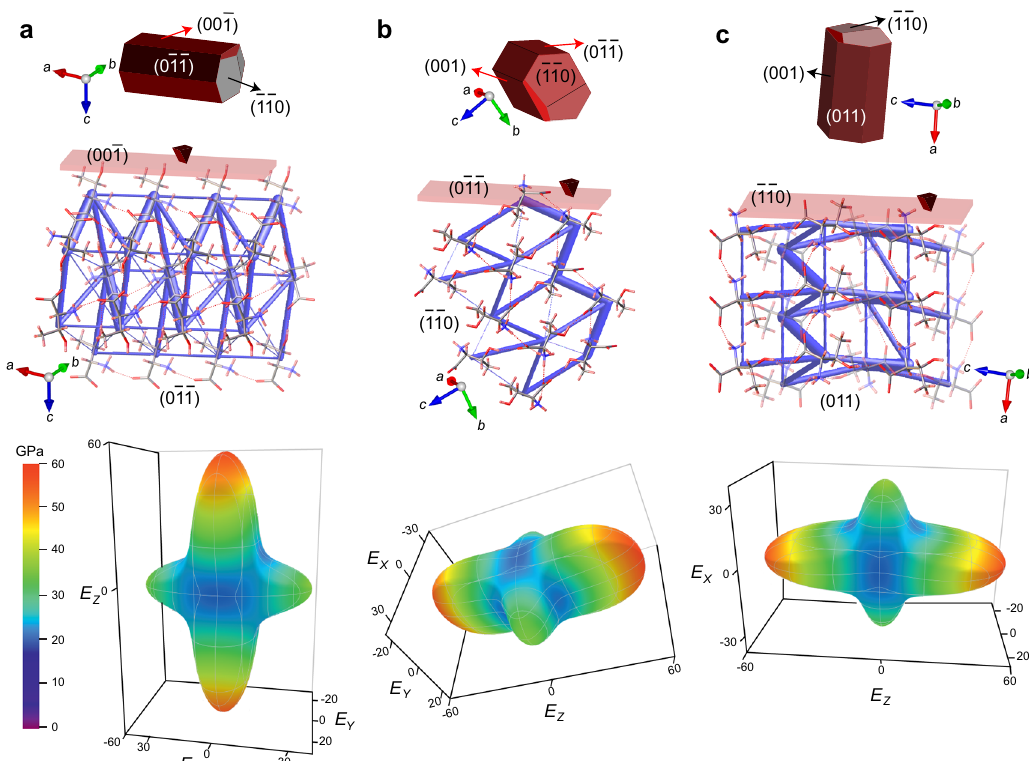
Fig. 2 Face indices, energy frameworks, and computed 3D surfaces of the Young ’ s modulus for L-threonine crystal. The properties are shown as viewed along faces: a (00 (cid:1) 1), b (0 (cid:1) 1 (cid:1) 1), and c ( (cid:1) 1 (cid:1) 10). Only the interaction energy component of the energy frameworks is shown as blue sticks. The thickness of each tube is proportional to the strength of the respective interaction. The scaling of the tubes is the same in all pictures. To improve the clarity of the pictures, the frameworks and crystal packing were reconstructed and merged, and interaction cutoff of 5 kJ mol − 1 was applied. The color-coded scale applies to all three plots of the Young ’ s